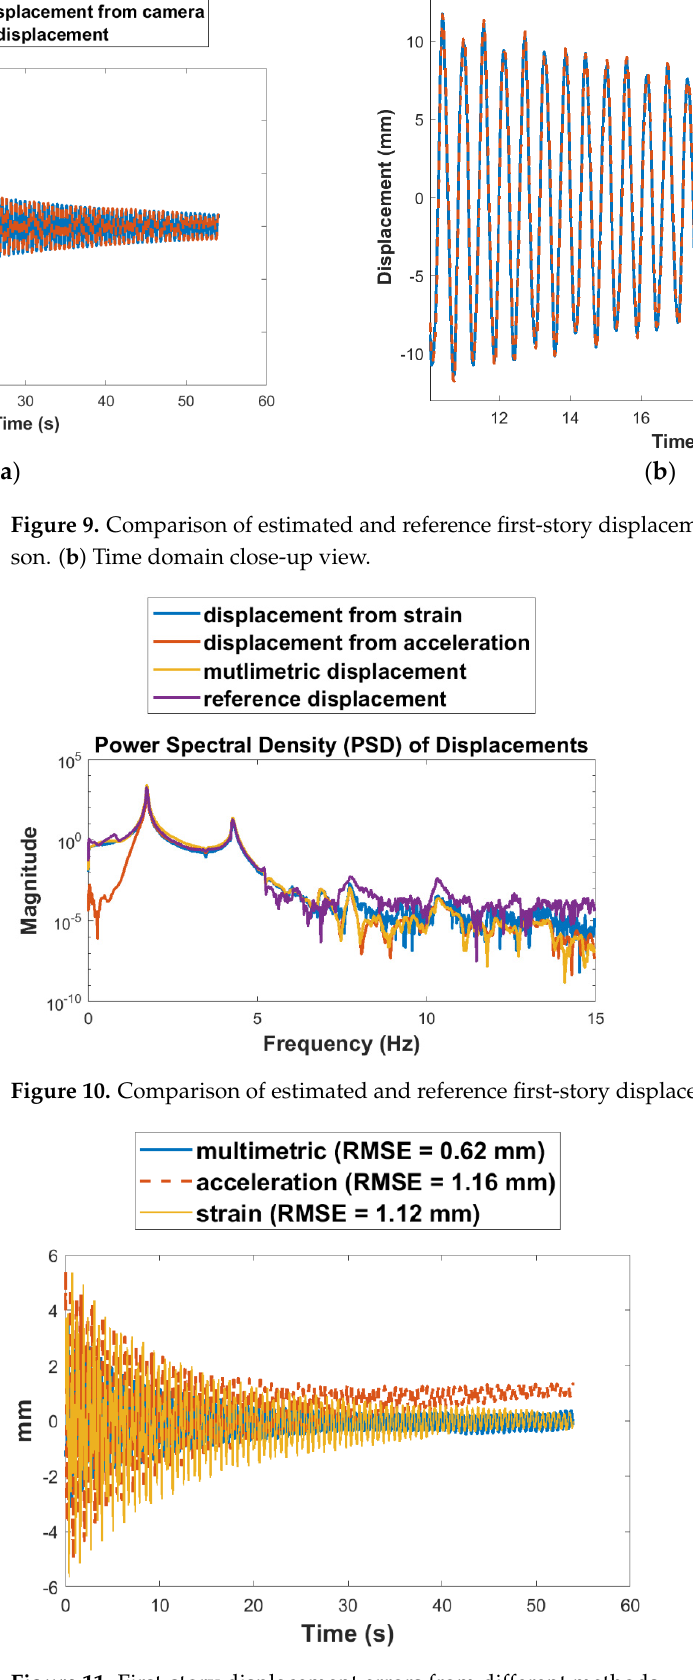
Figure 11. First-story displacement errors from different methods.